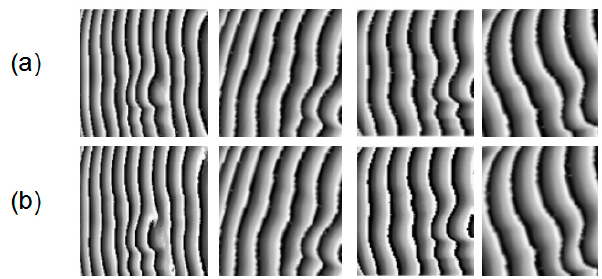
Figure 14. Calculated wrapped phase maps from ( a ) four-step phase-shifting method, and ( b ) neural network.